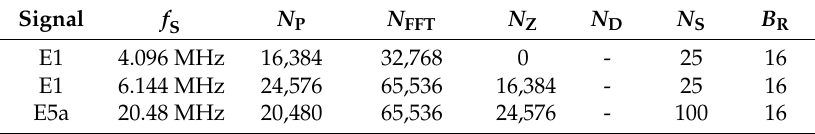
Table 14. Parameters independent of the integration time selected for Galileo signals.